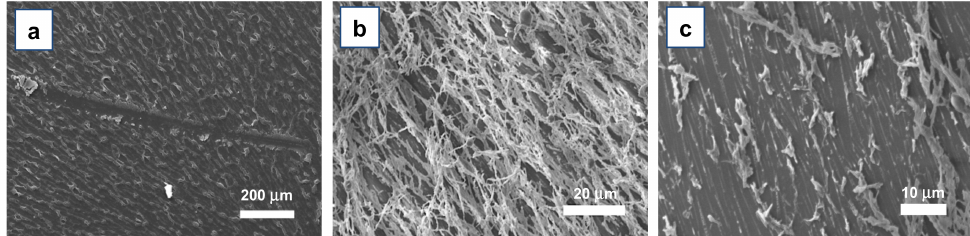
Figure 6. SEM photos of PLGA nanofibers deposited onto Si/SiOx and submitted to different tests. ( a ) fibers scratched with a metal spatula. ( b , c ): fibers obtained from a M100 solution before ( b ) and after ( b ) a tape detachment test. In Figure 6c, it is possible to notice that a few nanofibers remained attached to the substrate, though damaged, and that many parts of the fibers remained stuck on the substrate even if their upper part was removed by the